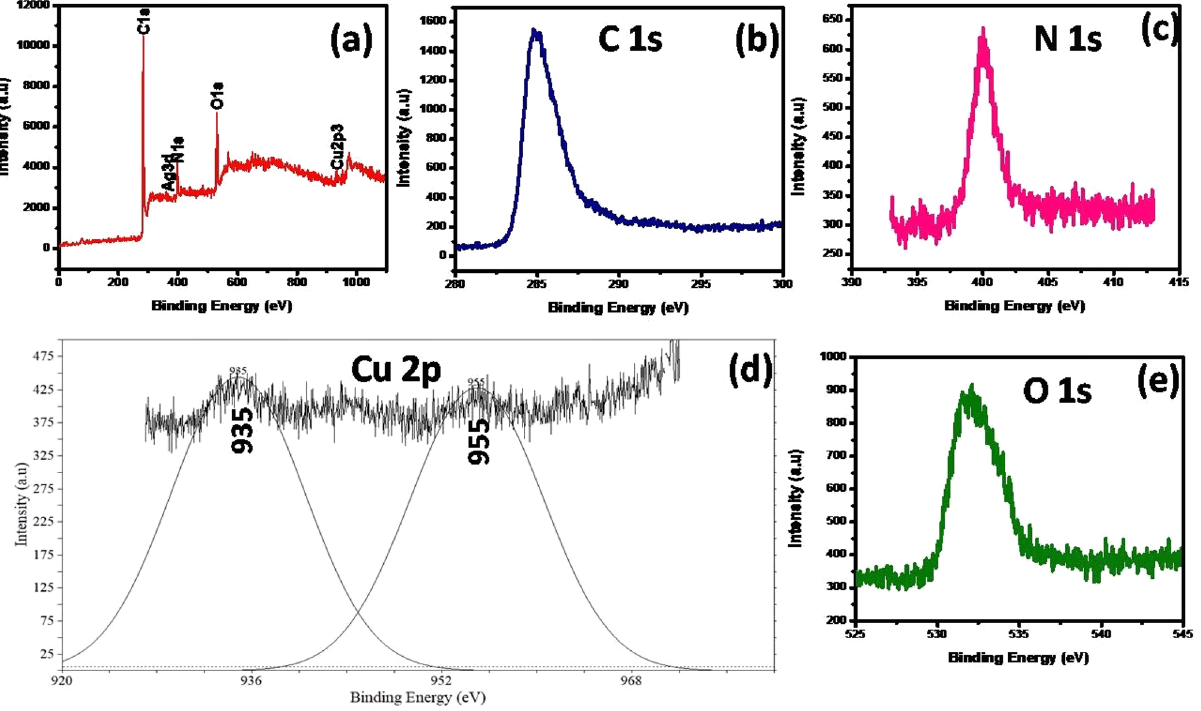
Figure 6. XPS analysis of ( a ) TCA NC, ( b ) C, ( c ) N, ( d ) Cu, and ( e ) O.